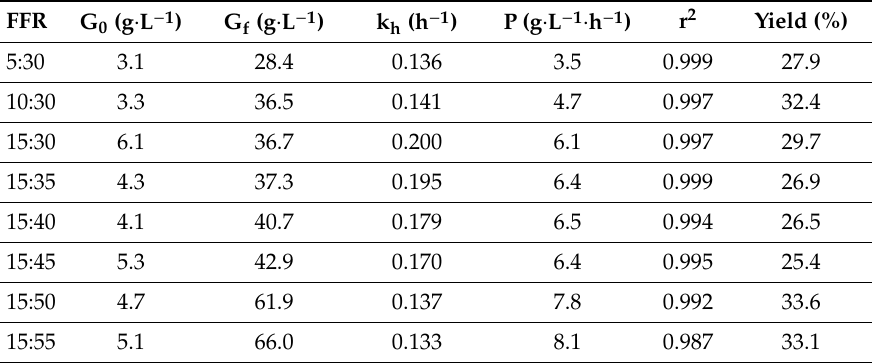
Figure 3. Evolution of RS concentration through hydrolysis time of fresh ESBPPs in 300 mL of citrate ‐ phosphate buffer (pH 5, 0.05 M) at 55 °C with various fermented to fresh solid ratios. FFRs of ( A ) 5:30 (star), 10:30 (triangle), and 15:30 (square) and ( B ) 15:30 (star), 15:35 (triangle), 15:40 (square), 15:45 (circle), 15:50 (diamond), and 15:55 (cross) are shown. Lines indicate theoretical values obtained from the kinetic model and symbols represent experimental values. Table 3. Effect of fermented to fresh solid ratio on hydrolysis experiments performed in 300 mL of citrate ‐ phosphate buffer (pH 5, 0.05 M) at 55 °C with various fermented to fresh solid ratios. G o : initial RS concentration, G f : theoretical maximum RS concentration, k h : hydrolysis rate (h − 1 ), and P: productivity (g ∙ L − 1 ∙ × h − 1 ).